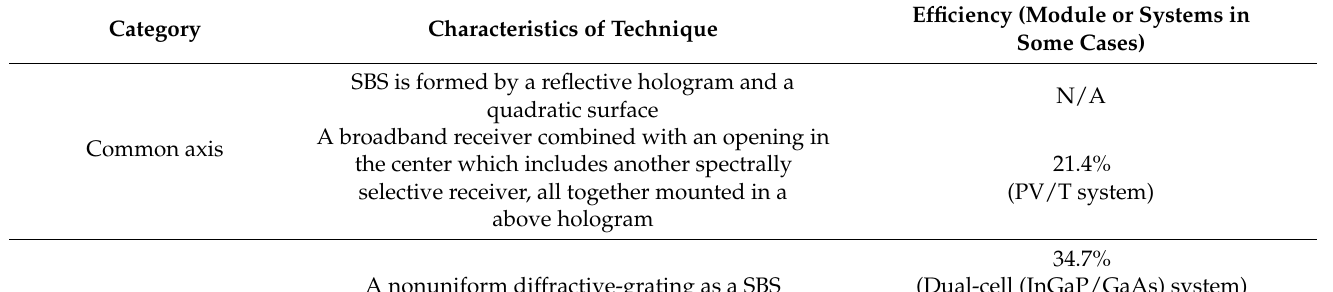
Multiple optical